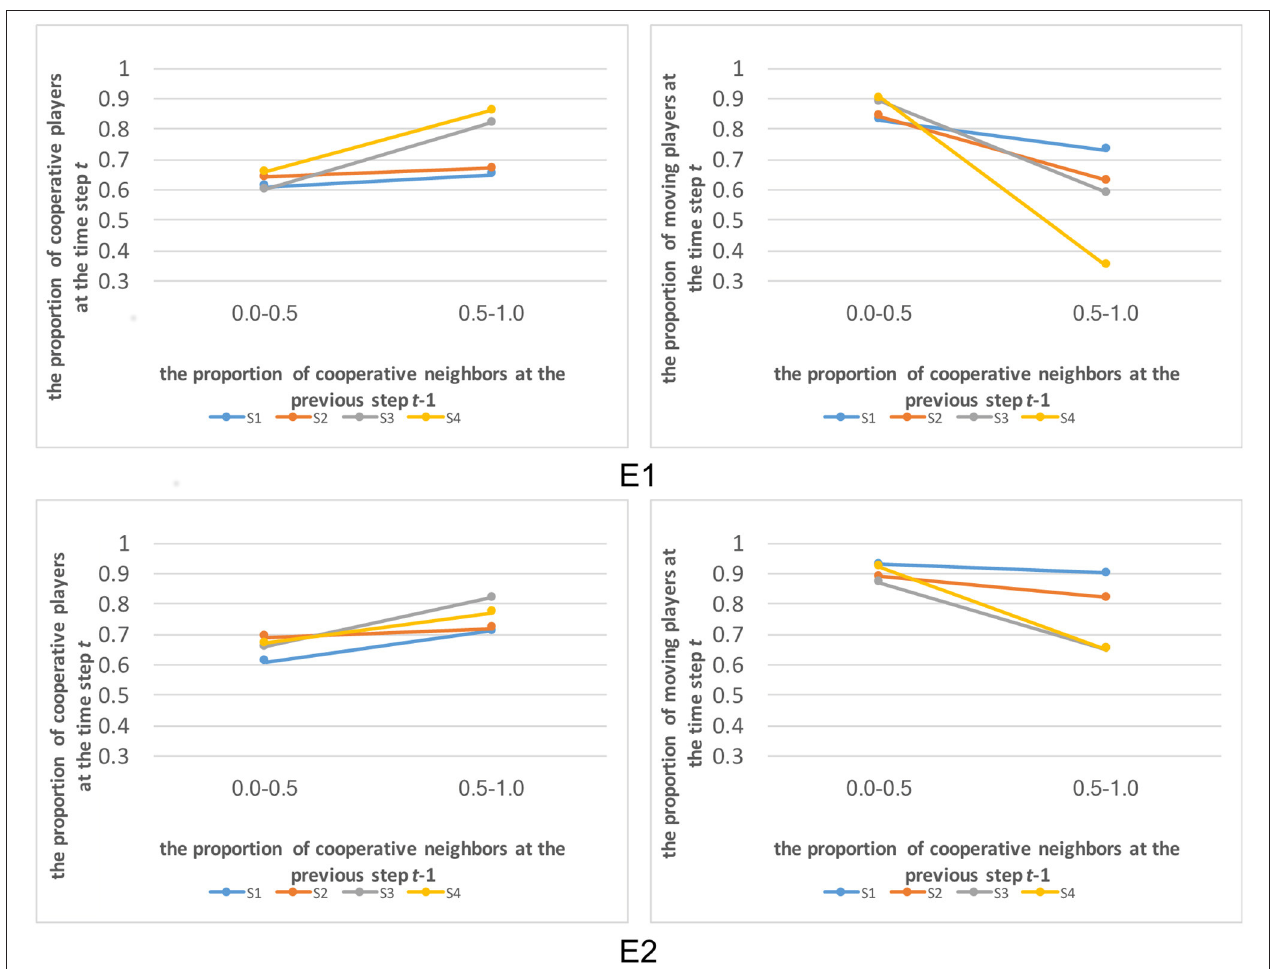
FIGURE 4 | The proportion of cooperative and moving players at step t when the proportion of cooperative neighbors was lower than 0.5 or not in the previous step t